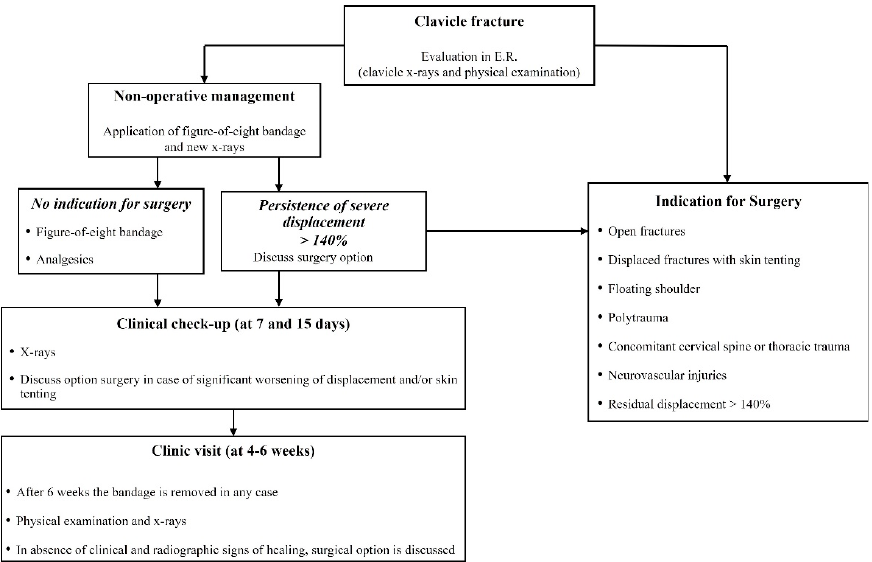
Figure 1. Institutional treatment protocol for displaced midshaft clavicle fracture of adult patients.